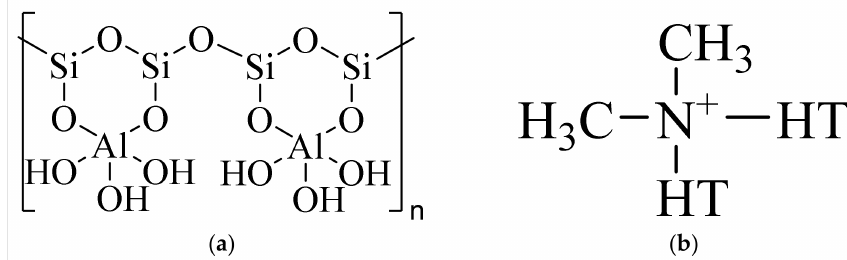
Figure 2. Scheme showing the structures of: ( a ) HNT; ( b ) C20A2.2.